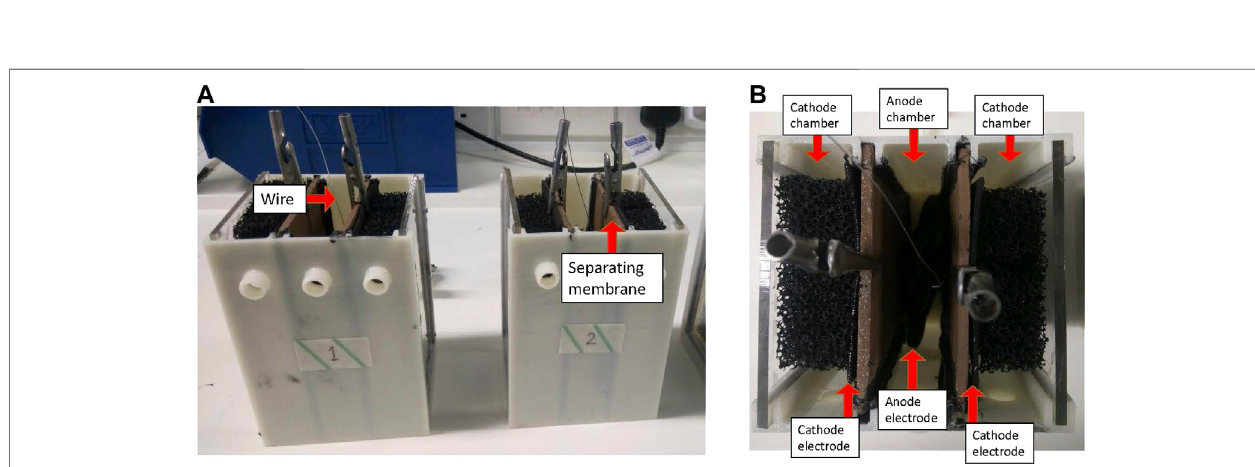
FIGURE 2 | Photographs of the MFCs used in laboratory experiments. (A) Front view and (B) top view.